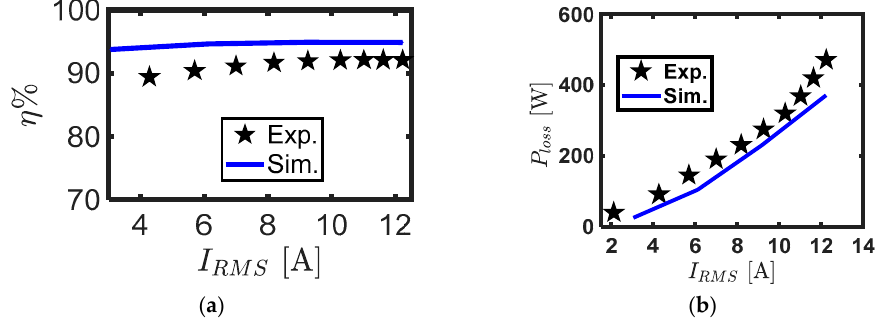
Figure 16. ( a ) Average output torque and ( b ) power factor at different line currents, at an optimal current angle, and at 𝑁 (cid:3045) = 1000 rpm .